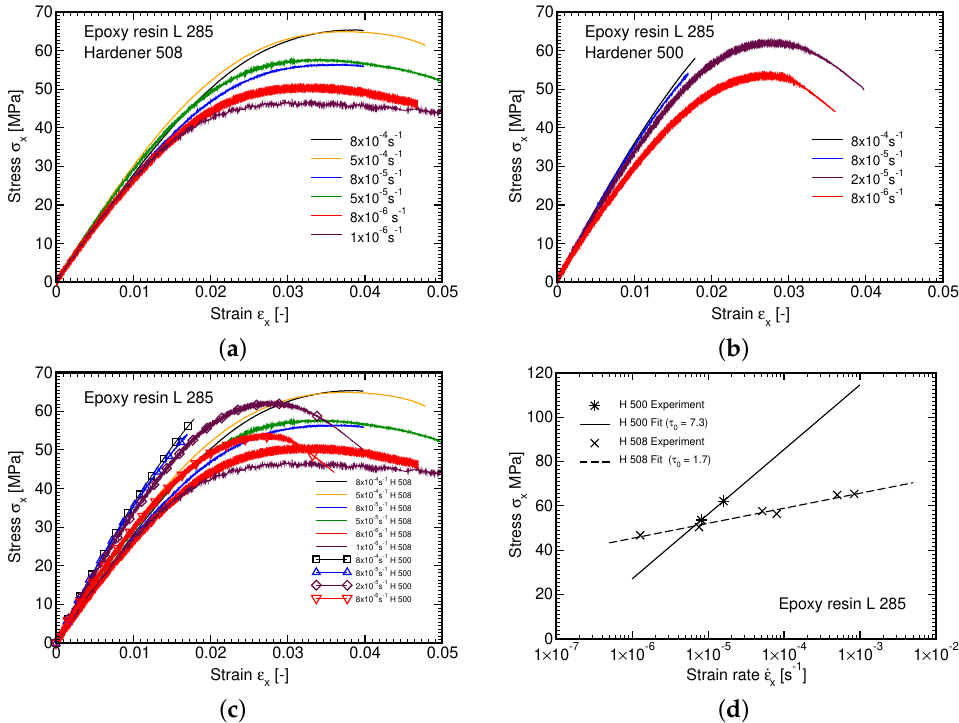
Figure 7. Tensile tests: ( a ) Hardener 508, ( b ) Hardener 500, ( c ) All tests, ( d ) Eyring plot.